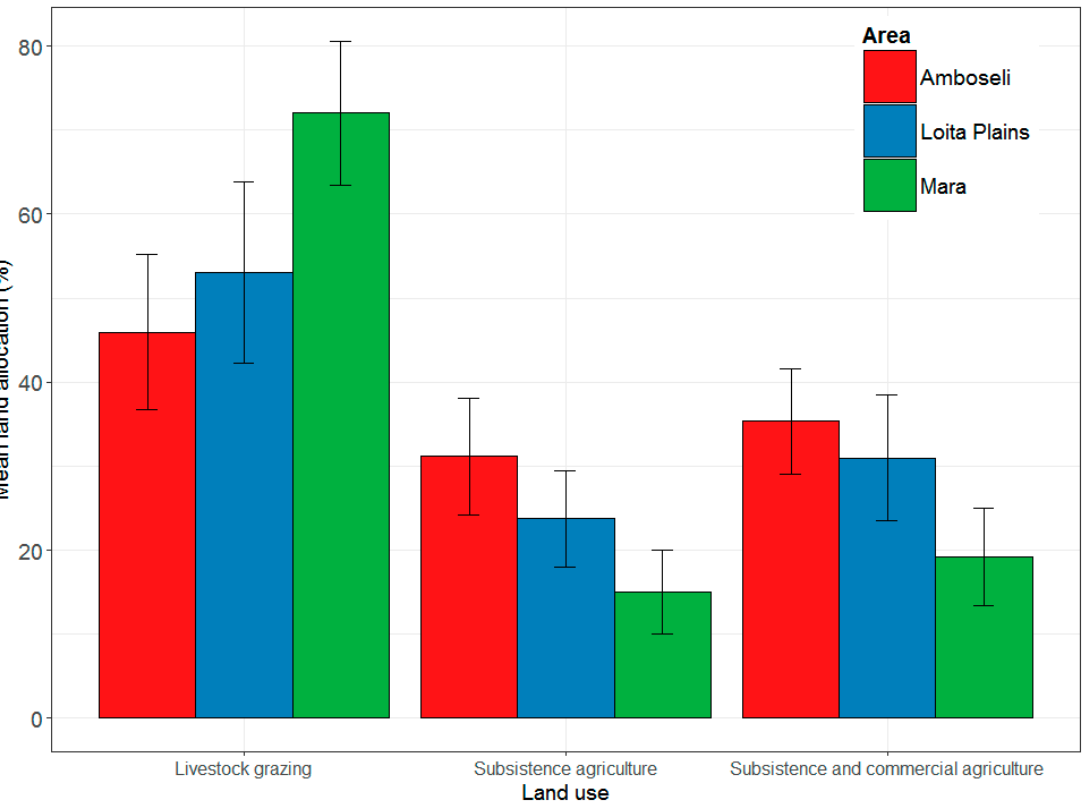
Figure 4. Proportion of livestock grazing and agricultural land uses on private land in Amboseli, the Loita Plains, and Mara. The error bars represent the standard error of the mean. Maize and beans are mainly grown for subsistence use, while fruits and vegetables such as tomatoes, cucumbers, onions, and green peppers are grown for sale.